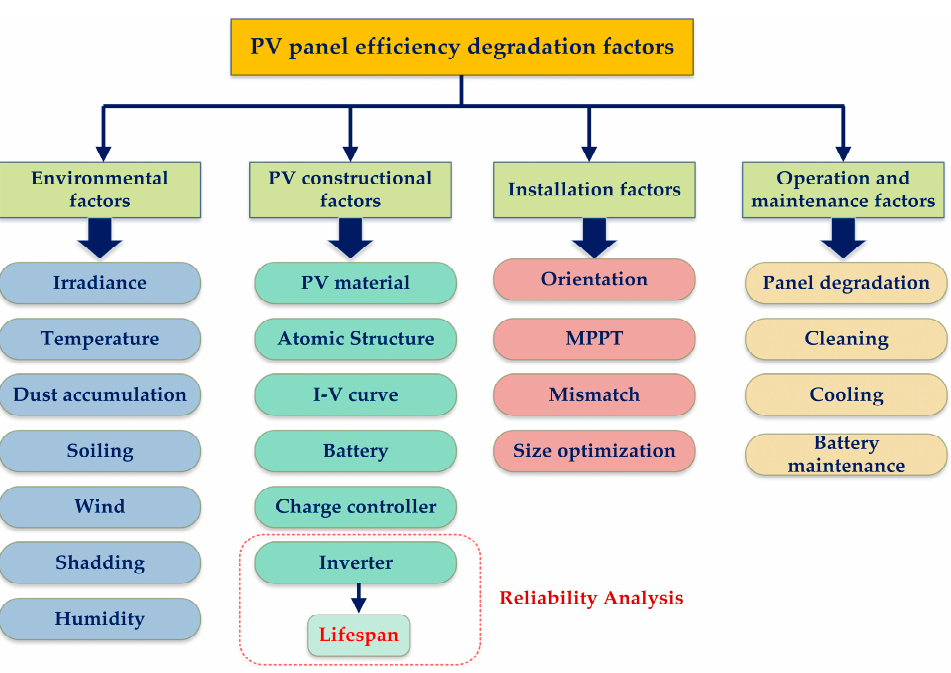
Figure 2. PV panel e ffi ciency degradation factors.